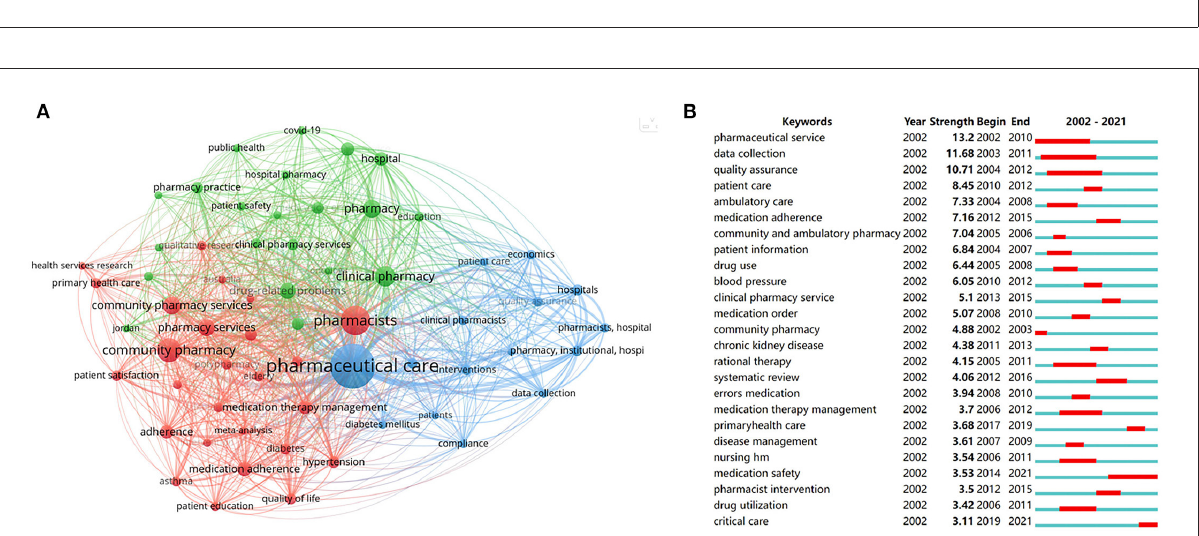
FIGURE7 Co-occurrence analysis of co-cited references cited more than 40 times.